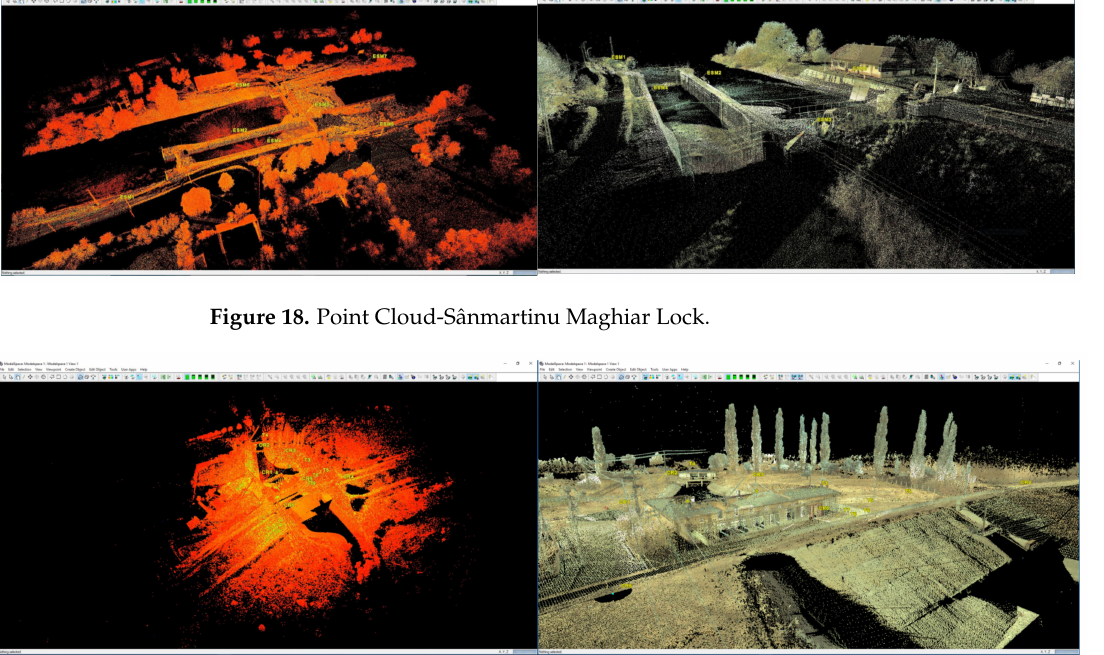
Figure 19. Point Cloud-Cruceni Pumping